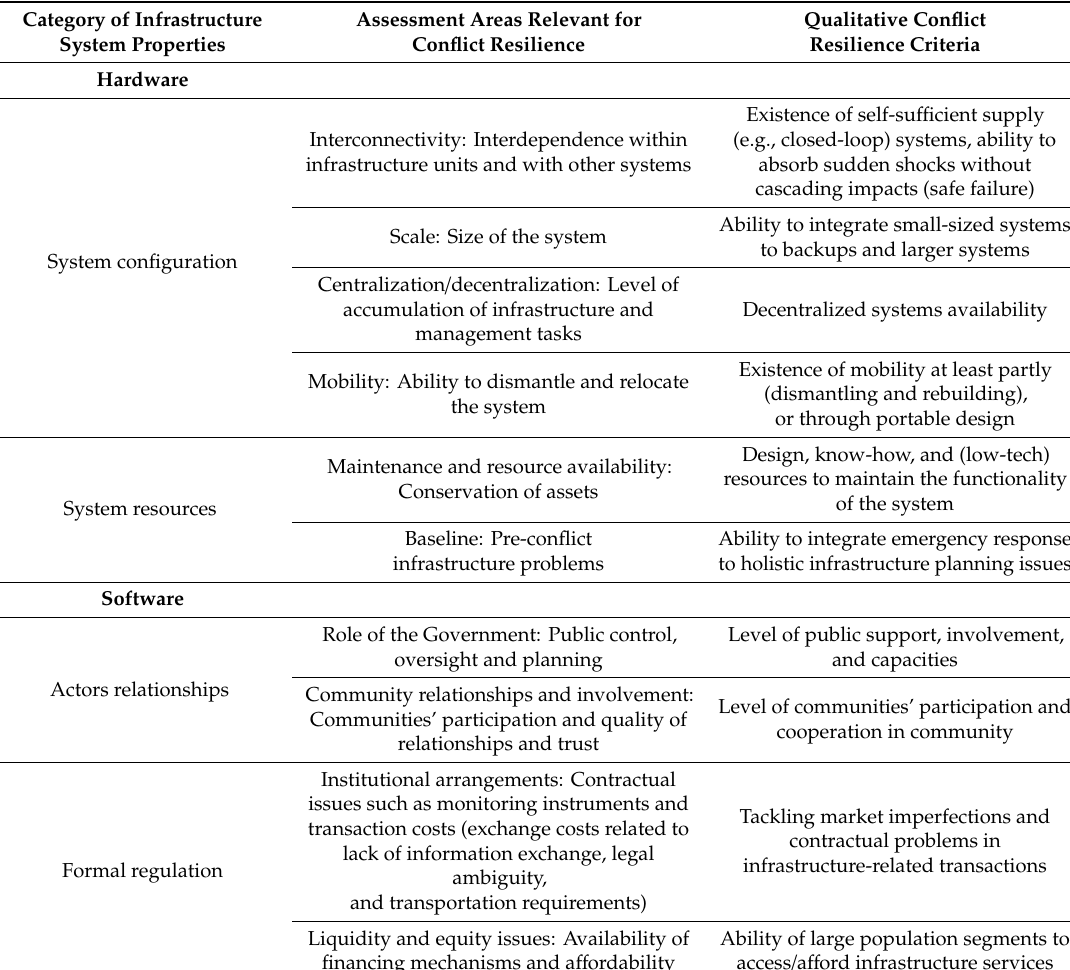
Table 1. Description of the rapid resilience assessment and used